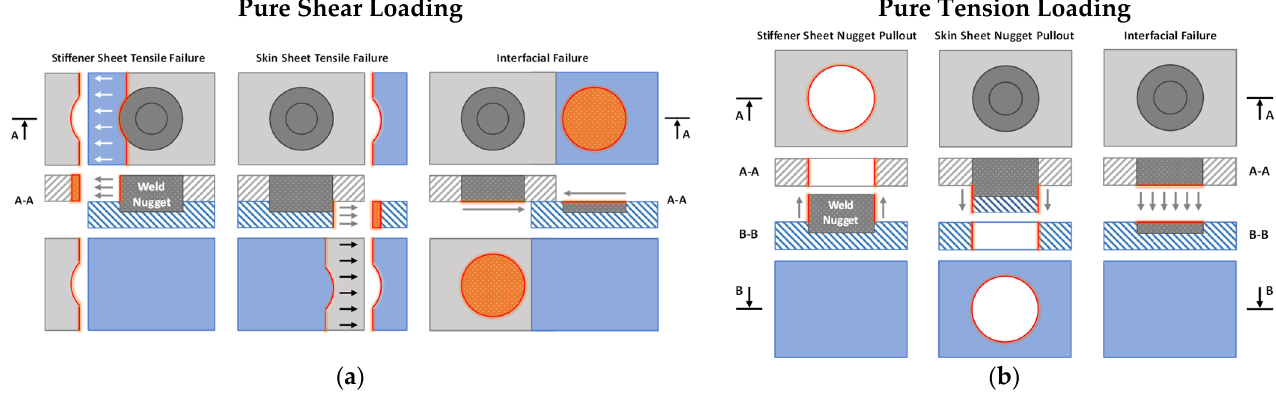
Figure 16. Schematics of refill spot weld failures: ( a ) parent metal tensile failures and an interfacial shear failure caused by pure shear loading and ( b ) nugget pullouts and an interfacial tension failure caused by pure tension loading. The graphics of each failure include the top view, the cross-section view, and the bottom view. The failure surfaces are highlighted in orange and red.